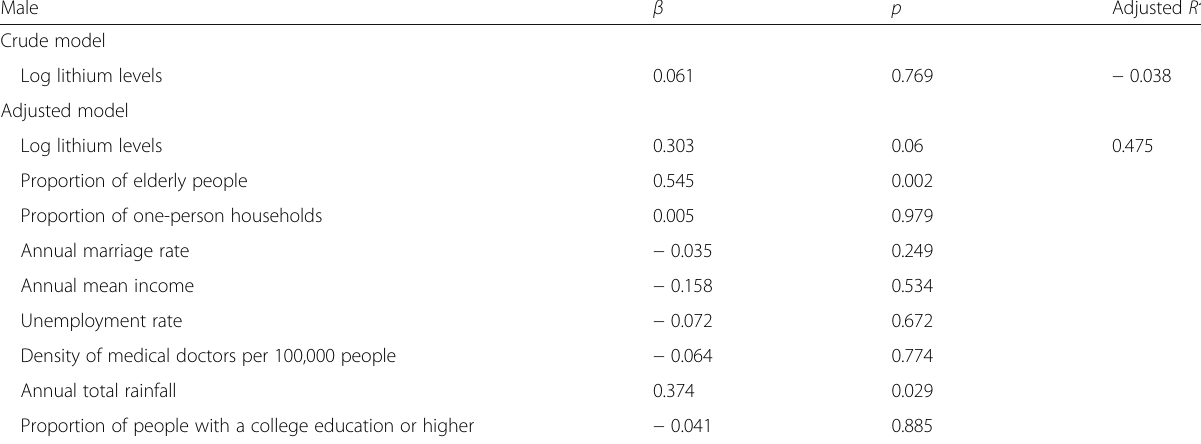
Table 1 Multiple regression analysis of male suicide SMRs and lithium levels in drinking water Male β p Adjusted R 2 Crude model Log lithium levels 0.061 0.769 − 0.038 Adjusted model Log lithium levels 0.303 0.06 0.475 Proportion of elderly people 0.545 0.002 Proportion of one-person households 0.005 0.979 Annual marriage rate − 0.035 0.249 Annual mean income − 0.158 0.534 Unemployment rate − 0.072 0.672 Density of medical doctors per 100,000 people − 0.064 0.774 Annual total rainfall 0.374 0.029 Proportion of people with a college education or higher − 0.041